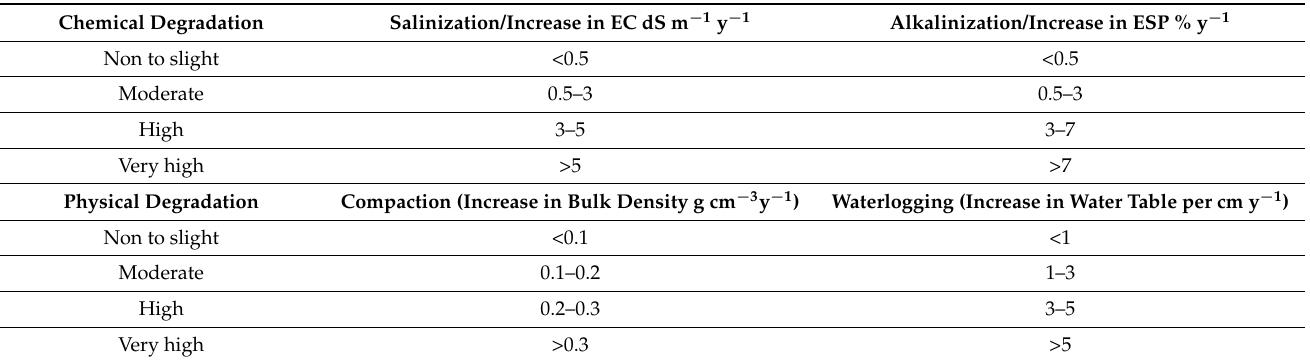
Table 3. Criteria used to determine the classes and rates of different types of degradation after FAO/UNEP [2].